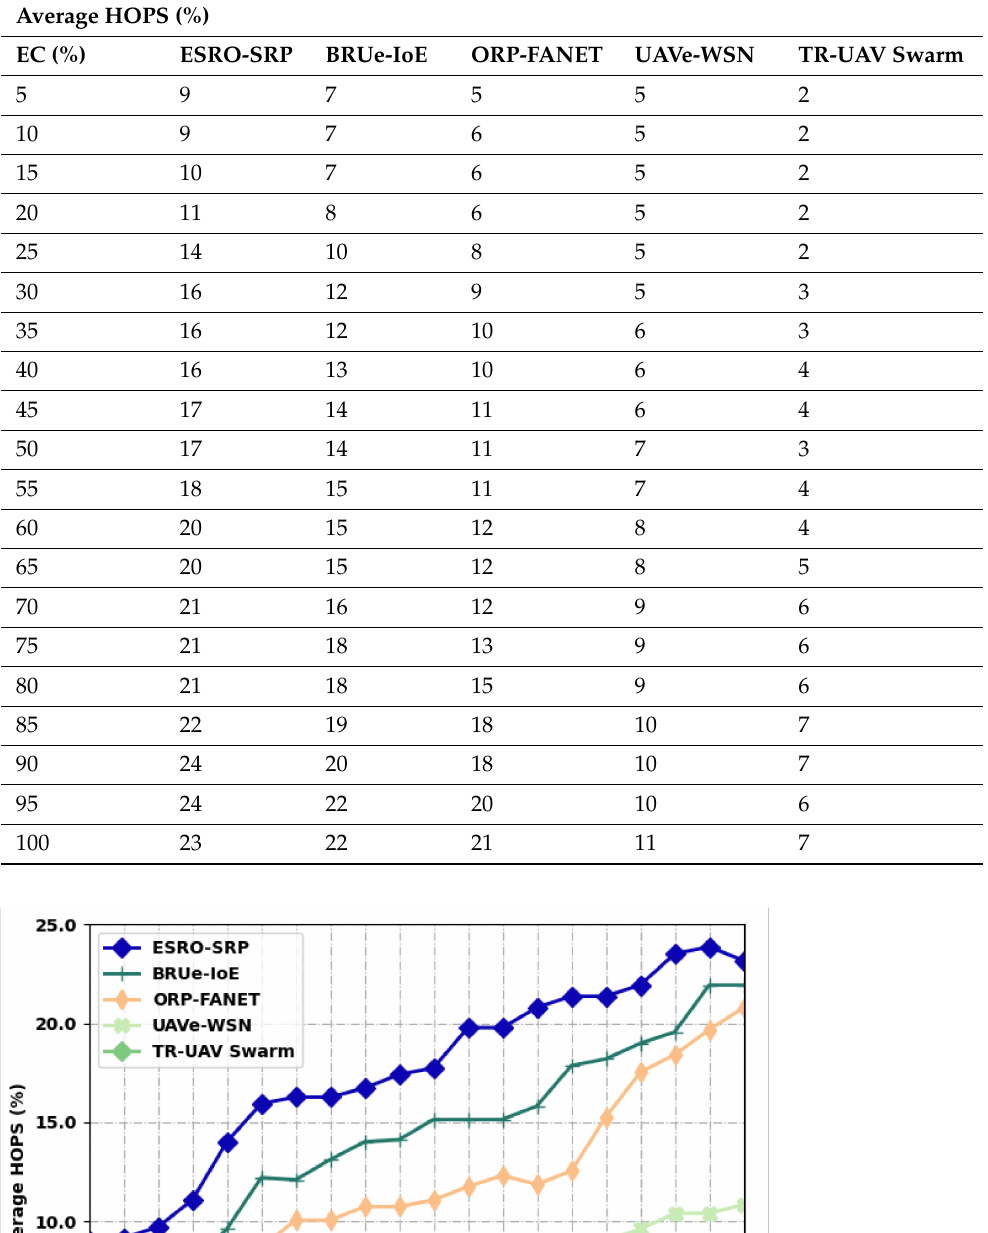
Table 3. Average HOPS analysis of ESRO-SRP technique with existing algorithms under distinct levels of energy.